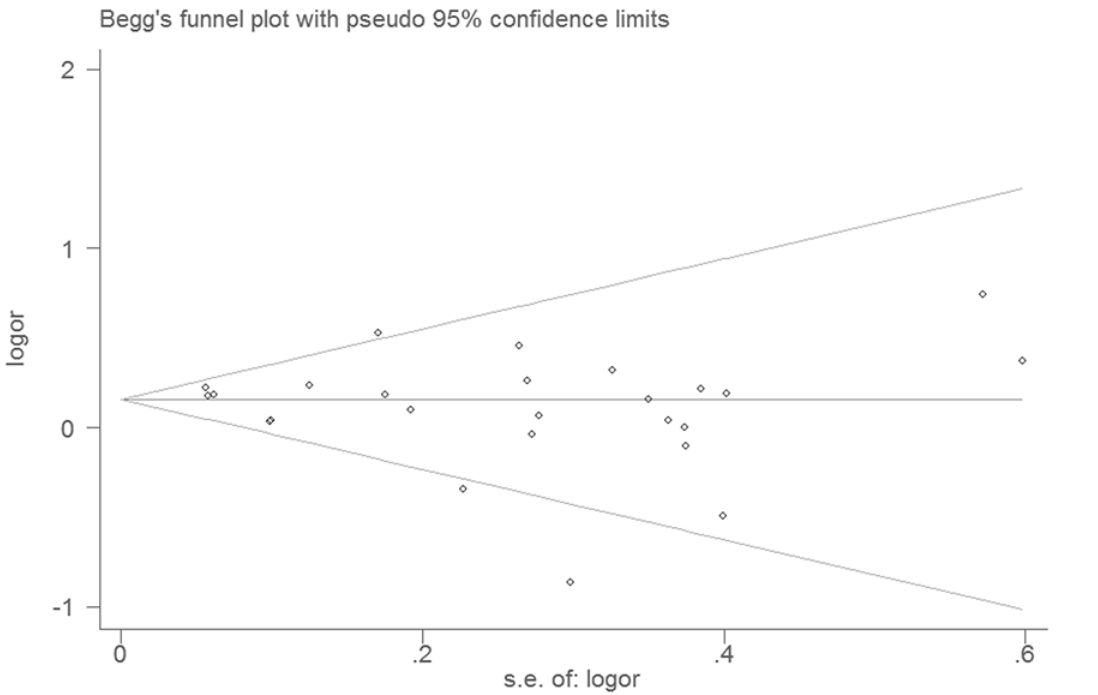
Fig 8. Begg ’ s test of studies reporting on maternal gestational smoking and risk of